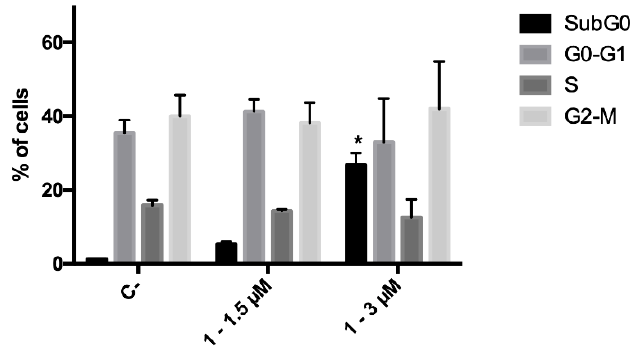
Figure 3. Cell-cycle distribution of CCRF–CEM cells after 24 h treatment with 1 . * p < 0.05 versus untreated cells. C-: negative control.